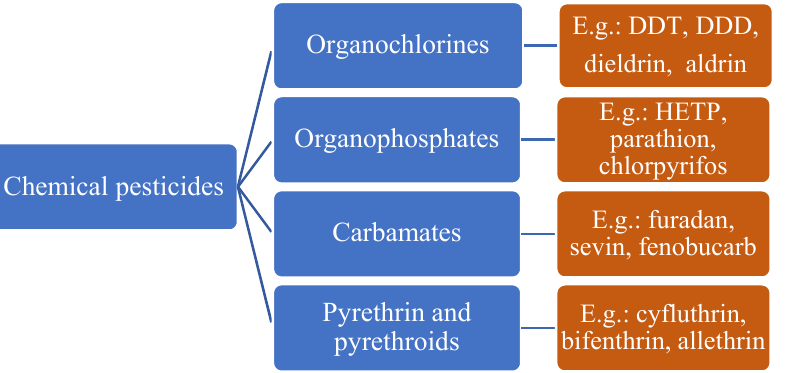
Figure 3. Classification of the chemical pesticides. DDT: dichlorodiphenyltrichloroethane; DDD: dichlorodiphenyldichloroethane; HETP: hexaethyl tetraphosphate. Table 2. Chemical composition of the pesticides. Group Chemical Structure